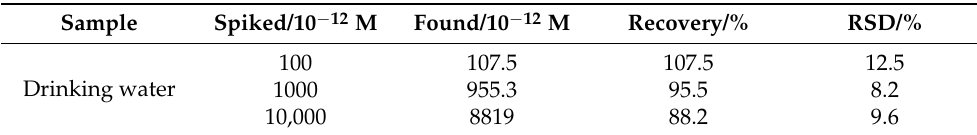
Table 1. Analytical results of OFL detection in drinking water ( n = 3).